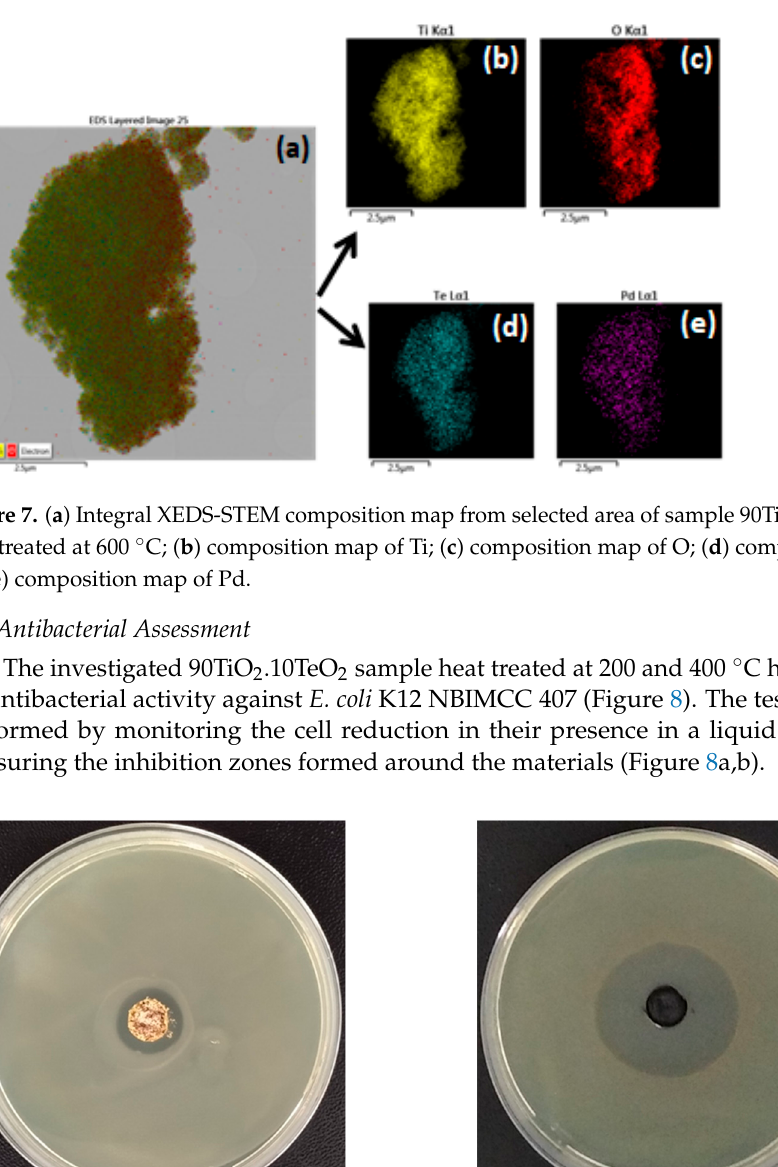
Figure 6. ( a ) Integral XEDS-STEM composition map from selected area of sample 90TiO 2 /10TeO 2 heat treated at 600 °C; ( b ) composition map of Ti; ( c ) composition map of O; ( d ) composition map of Te.